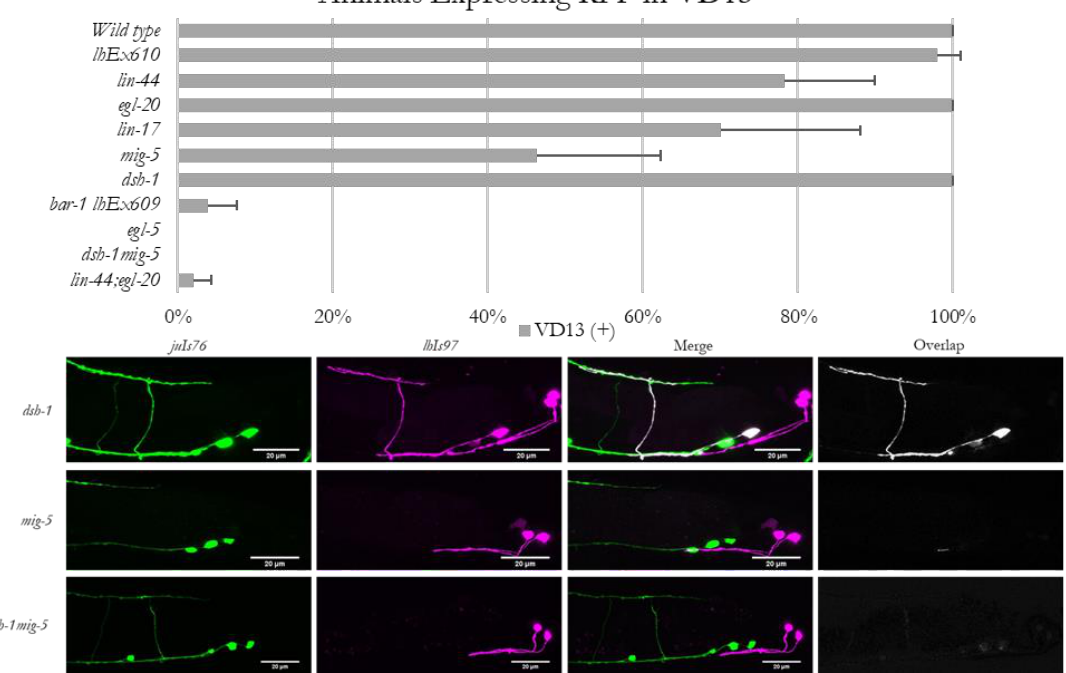
Figure 3. Expression of lhIs97 is selectively lost in VD13 in Wnt loss of function animals. Animals were scored for the presence or absence of RFP in VD13. The percentage of animals (mean ± s.d.) that expressed RFP in each genetic background is presented in the graph. Below are examples of RFP expression being present in VD13 in dsh-1 mutants, but absent in the majority of mig-5 single mutants and all dsh-1mig-5 double mutants.